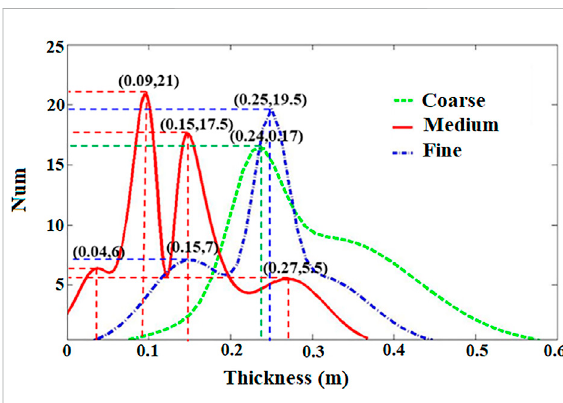
FIGURE 5 Shale layer thickness distribution for different sediment grain sizes.